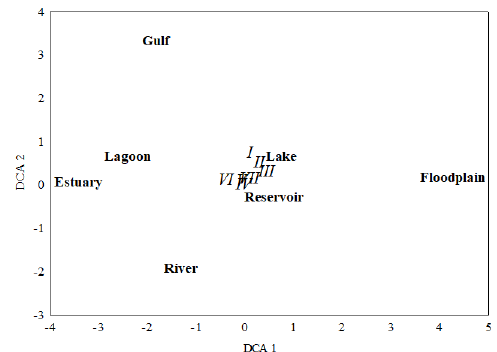
Figure 5. Detrended Correspondence Analysis for the association between MBFG and types of environments recorded in the global scientific literature between 2010 and